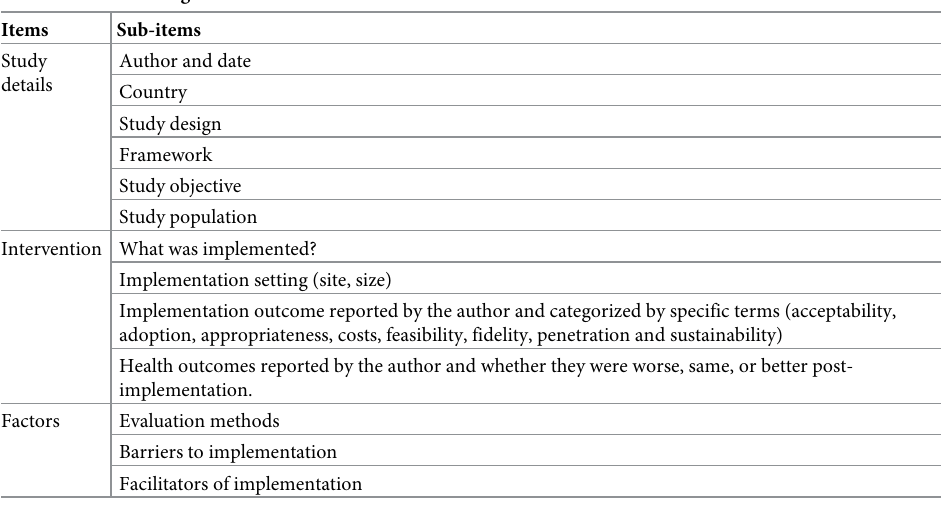
Table 1. Data charting items for included